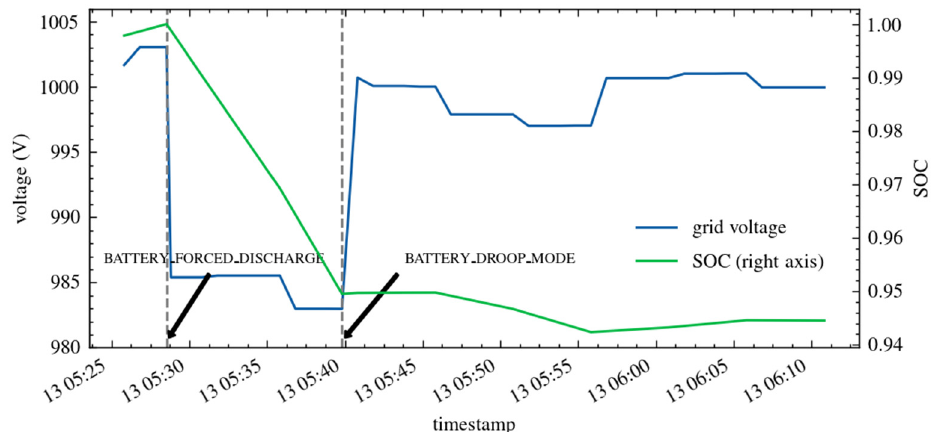
Figure 16. Grid voltage and battery SOC in Scenario 3: zoom on time instants corresponding to temporary working conditions of the battery (timestamp is in “day hours:minutes” format).